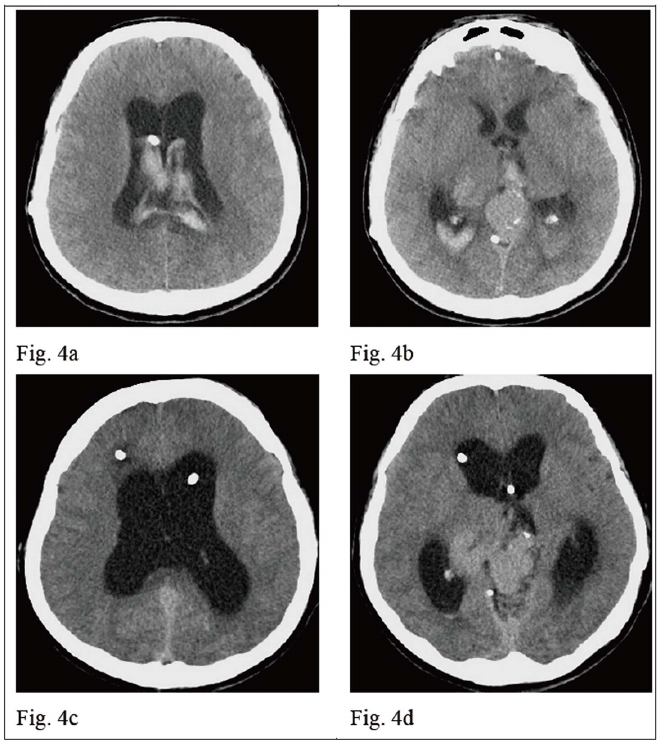
Fig 4. The change of brain CT scans in an intraventricular hemorrhage with hydrocephalus patient (case 2) in 7 days. Fig 4a. and 4b show that the initial brain CT revealed a thalamic vascular lesion and intraventricular hemorrhage in enlargedbilateral ventricles. A right VP shunt tube was placed in the right frontal horn. Fig 4c. and 4d show that the follow-upbrain CT on POD 7 revealeda stationary thalamic vascular lesion and regressionof intraventricular hemorrhage. Hydrocephalus was persistent and two EVD tubes were placed in the bilateral frontal horns.